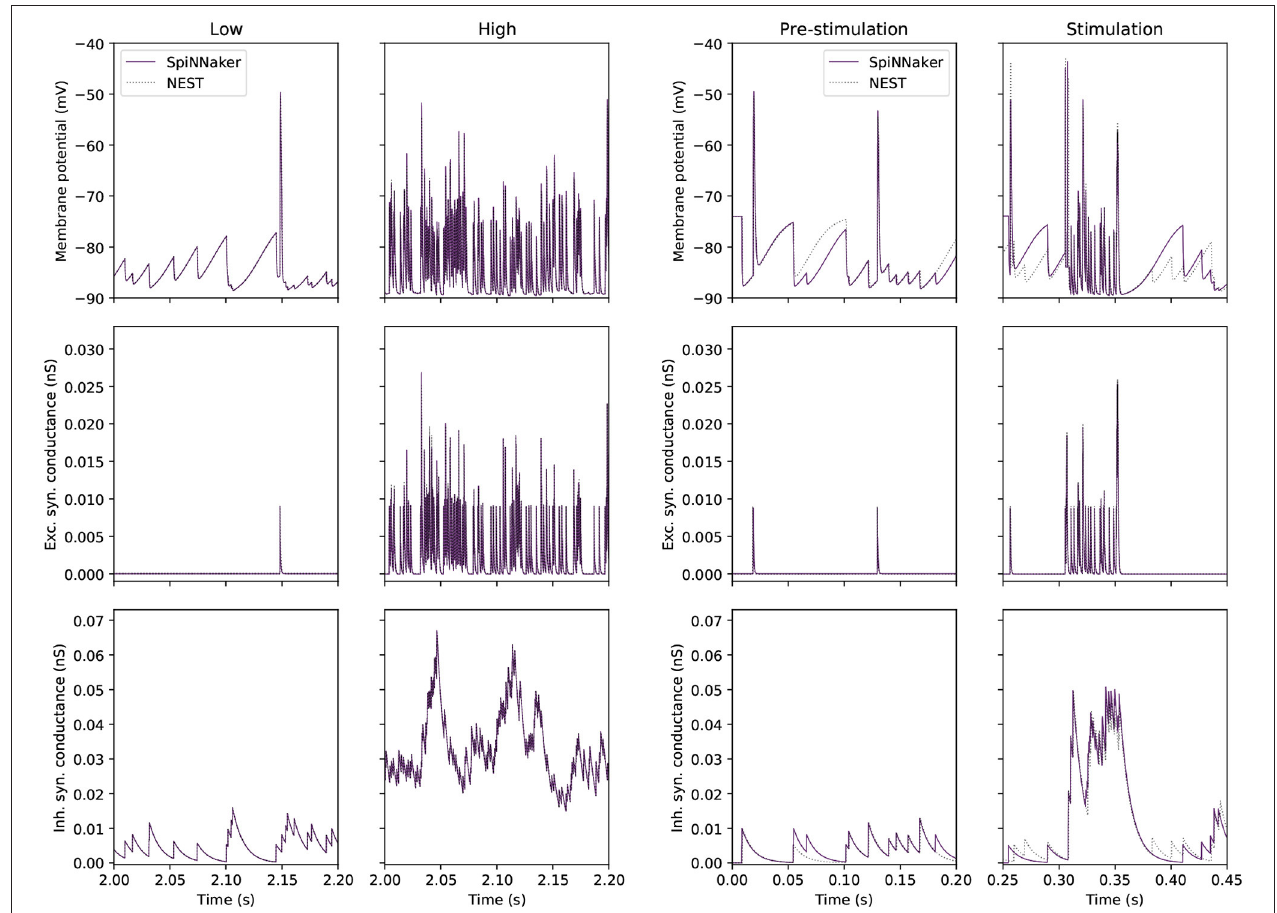
FIGURE 3 | Single GrC behavior in “low” and “high” input conditions for SpiNNaker (solid) and NEST (dotted) simulations. (Left) Traces extracted from the single cell experiment. (Right) Traces extracted from a single GrC embedded in the large-scale model where the pre-stimulation period corresponds to the “low” activity case, and the stimulation period corresponds to the “high” activity